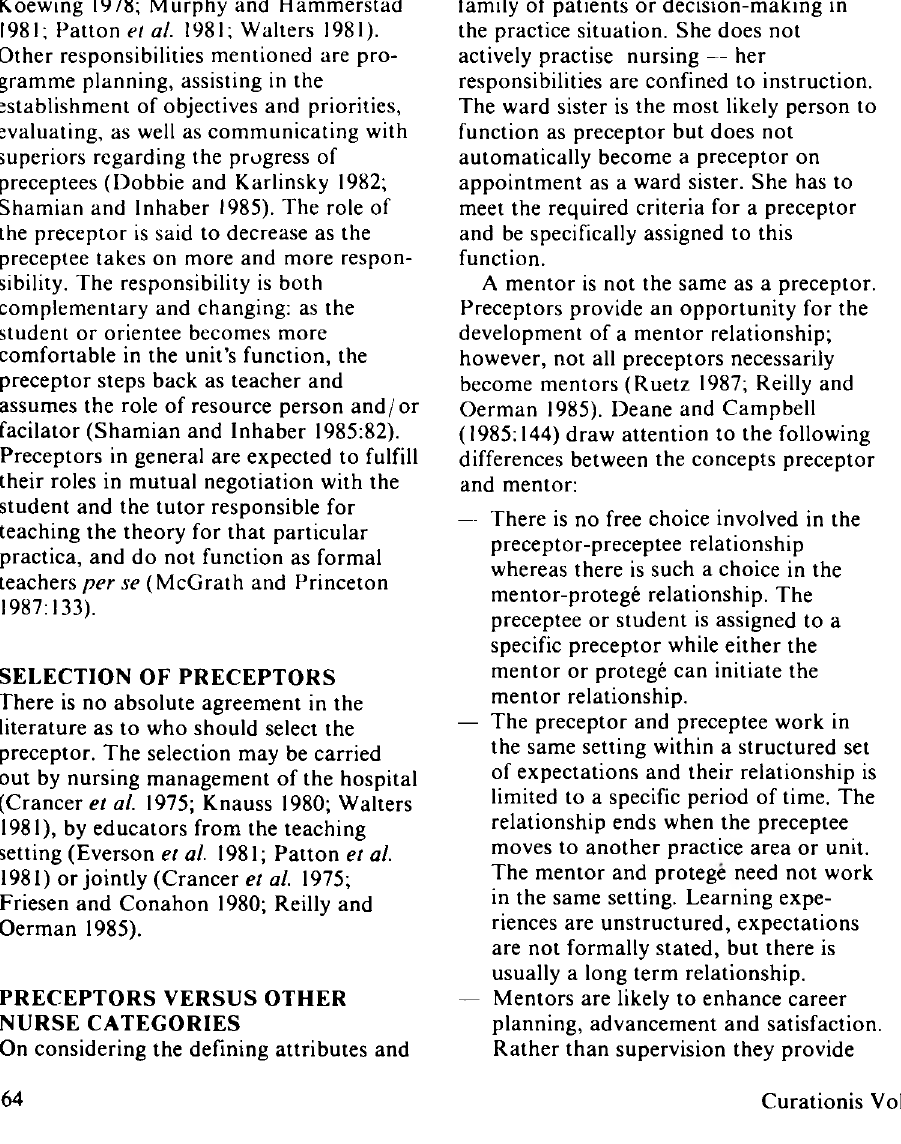
TABLE 1 Interpretation oj the term preceptor by respondents (n =